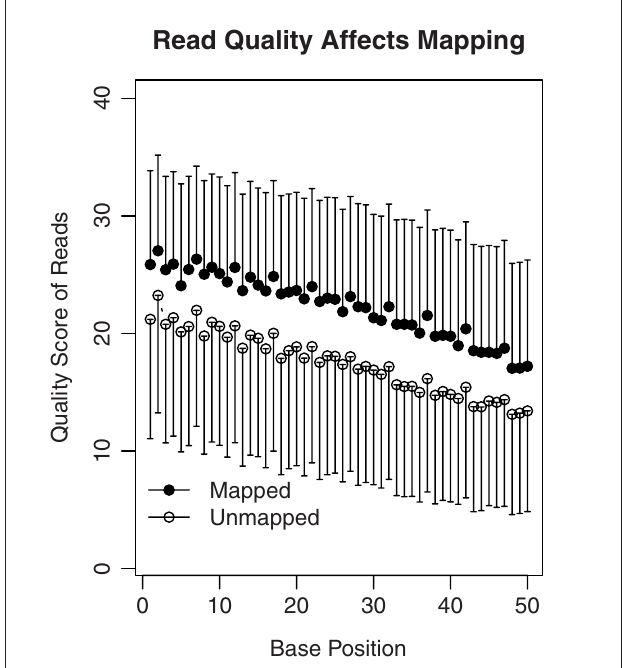
FiGuRe 3 | The quality of sequencing reads affects mapping. A total of 78 million 50-bp reads were obtained for rat 1. Among them, 35.8 million reads were mapped to the genome or known splicing sites. The mean quality scores of the mapped vs the unmapped reads were plotted. In general, the quality scores declined over the sequencing runs (i.e., from base 1 to 50). On average, the unmapped reads had quality scores 4.74 ± 0.42 lower than those that were mapped. Thus, lower quality of the read data is likely one of the reasons many reads are not mappable.